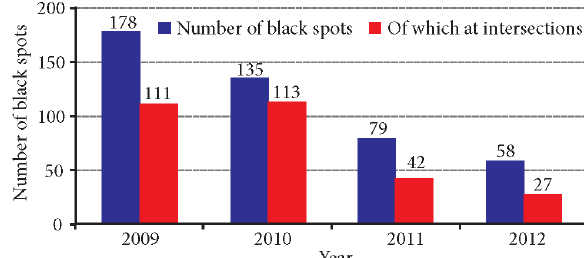
Fig. 1. The change in the number of black spots on the